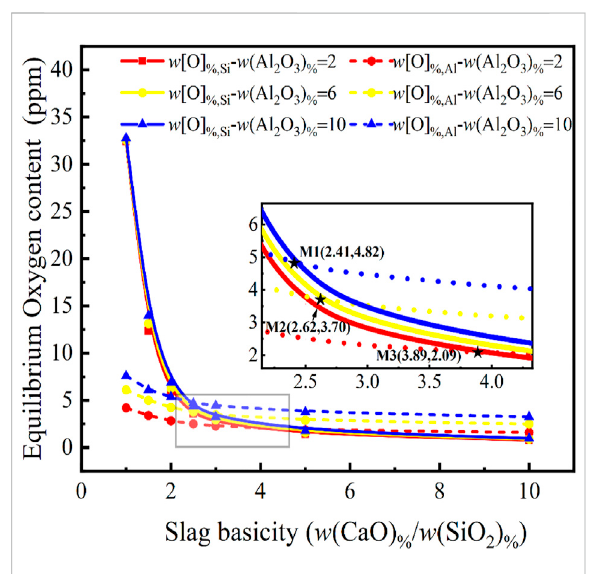
FIGURE 2 Relationship between basicity in CaF 2 -CaO-Al 2 O 3 -MgO- SiO 2 slag and Al 2 O 3 content on the equilibrium oxygen content at 1,873 K for a certain molten steel composition { w [Si] % = 5.0, w [Al] % =